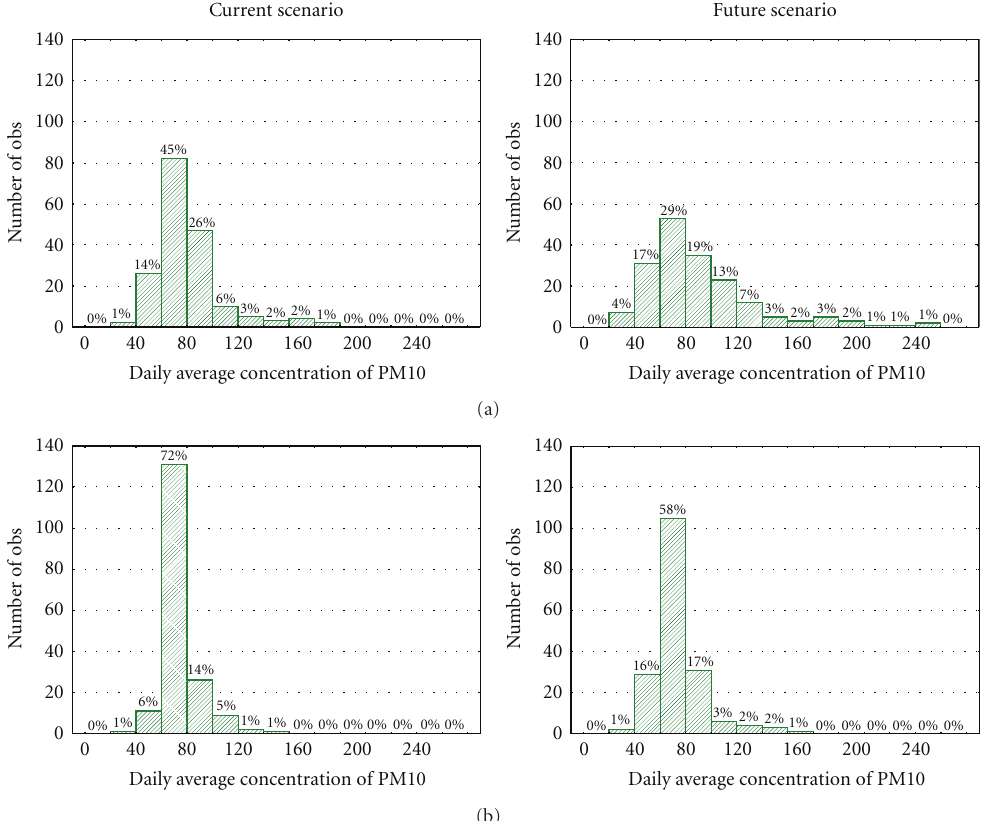
Figure 9: Frequency distribution of the PM10 concentrations for both climatic scenarios over the regions of (a) Porto and (b)